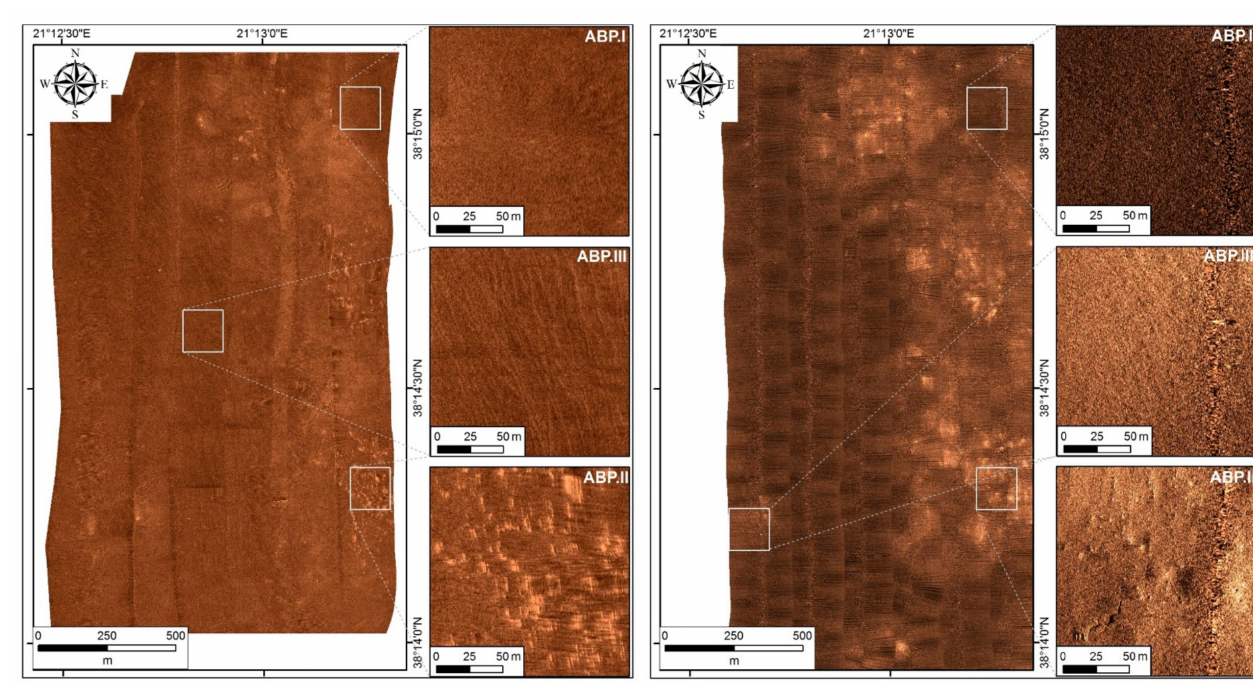
Figure 3. Side-scan sonar mosaics at 100 kHz ( left ) and 400 kHz ( right ) of the “many target” area and representative sonographs of the three acoustic backscatter patterns.